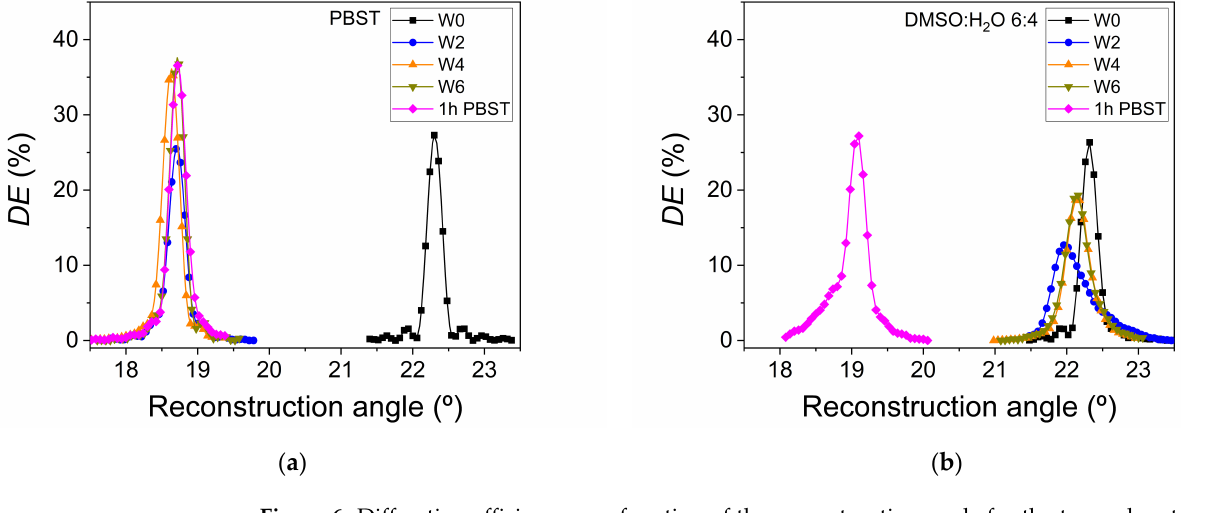
Figure 6. Diffraction efficiency as a function of the reconstruction angle for the two solvents used in the washing stage: ( a ) PBST; ( b ) DMSO:H 2 O 6:4. After exposure (W0, black square), after two washing steps (W2, blue circle), after four washing steps (W4, orange triangle), after six washing steps (W6, dark yellow triangle) and after one hour immersed in PBST (1 h PBST, magenta